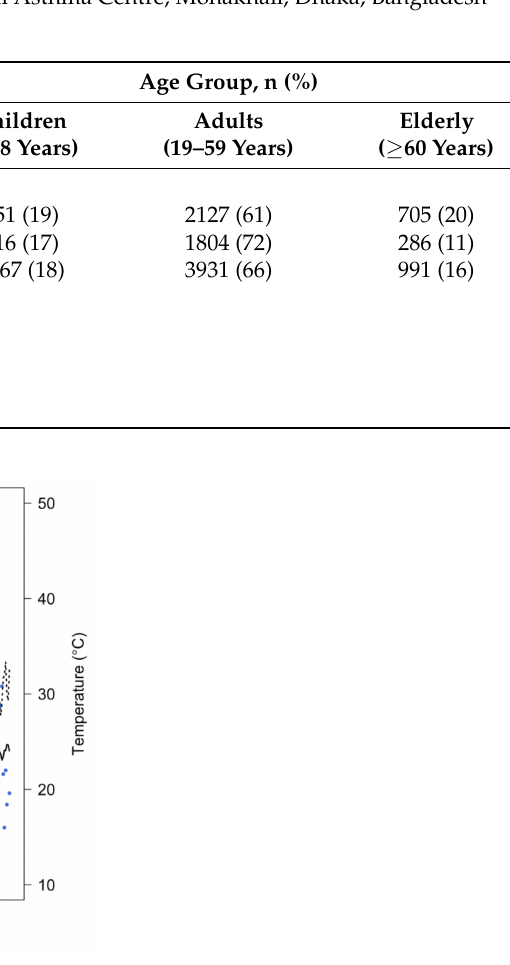
Figure 2. Distribution of daily nebulized asthma hospital visits (dot), mean temperature (solid line), mean relative humidity (dashed line), and strike events (short vertical bar at the bottom) near